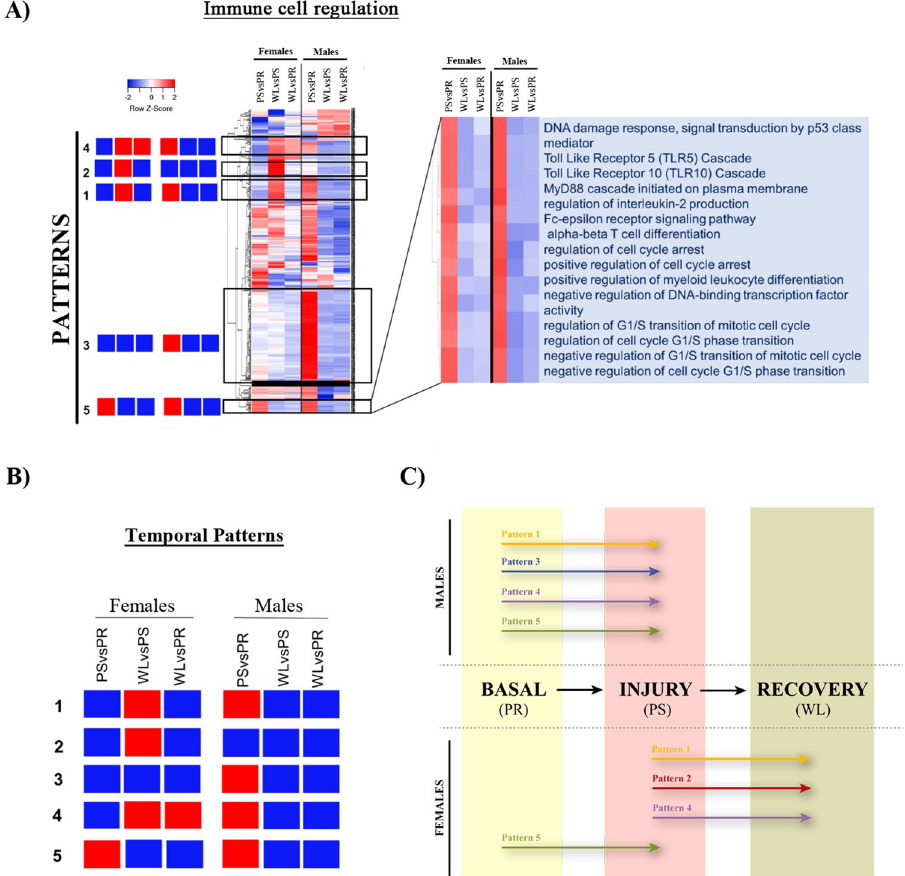
Figure 7. Patterns of gene sets regulation in male and female kidneys throughout renal IRI in the time comparison. An example of the gene sets of selected clusters represented by hierarchical clustering. ( A ) Heatmap (of time comparisons) was created with the normalized enrichment score (NES) values of the gene sets calculated by GSEA analysis. The red and blue colors refer to gene sets that are over- or under-represented in the heat-maps. ( B ) Five prominent patterns for time comparison were determined. ( C ) A summary of these five temporal patterns is depicted in a diagram, where patterns displayed in each sex are illustrated by a colored arrow positioned at the time point where they are up-regulated (PR, PS, WL). PR pre-ischemia, PS post- ischemia, WL one week